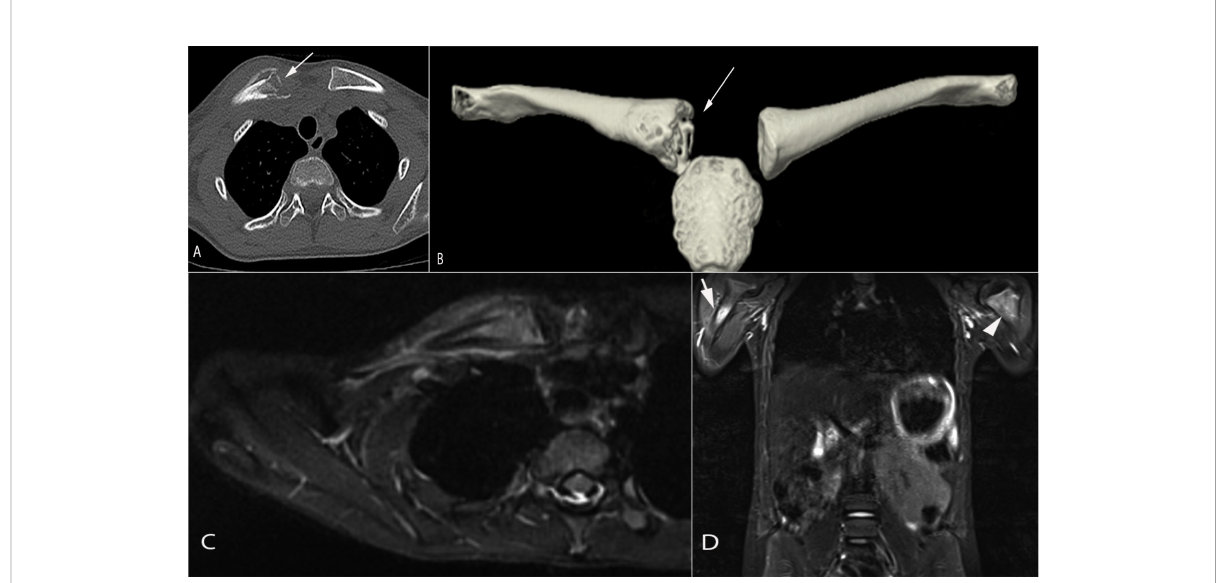
FIGURE 2 An 8-year-old girl presented with a painful lump on the right clavicle. Axial (A) and 3D reformats (B) computed tomography images demonstrate a destructive lesion in the medial aspect of the right clavicle associated with periosteal reaction and soft tissue swelling (arrow in a/b). Axial T2 STIR magnetic resonance image (C) showed a marked signal abnormality involving the medial aspect of the right clavicle with associated periosteal fl uid and soft tissue edema. Total body MRI-STIR sequences (D) showed additional lesions in the proximal right (arrow) and left (arrowhead) humeral metaphysis, right iliac crest (not shown)and left greater trochanter (not shown). Findings are consistent with CRMO following a Whole Body MRI.